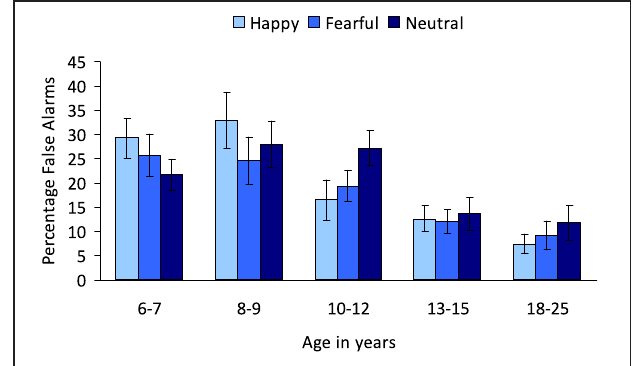
FIGURE 4 | Percentage false alarms on the colored emotional go/nogo task. Participants were instructed to respond to colors and emotion was an irrelevant dimension.